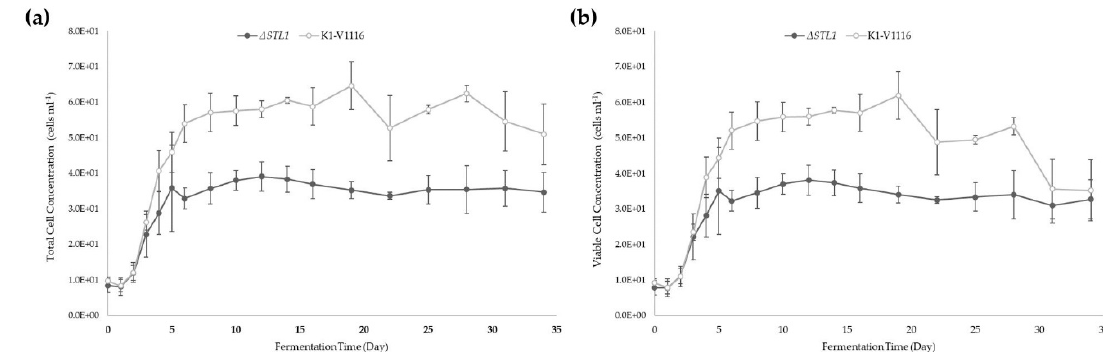
Figure 6. Reducing sugar consumed during fermentation. Fermentations of K1-V1116 ∆ STL1 ( ● ) and K1-V1116 ( ○ ) were performed in triplicate, with samples from each trial being analyzed in duplicate. Sugar values represent the average ± standard deviation.